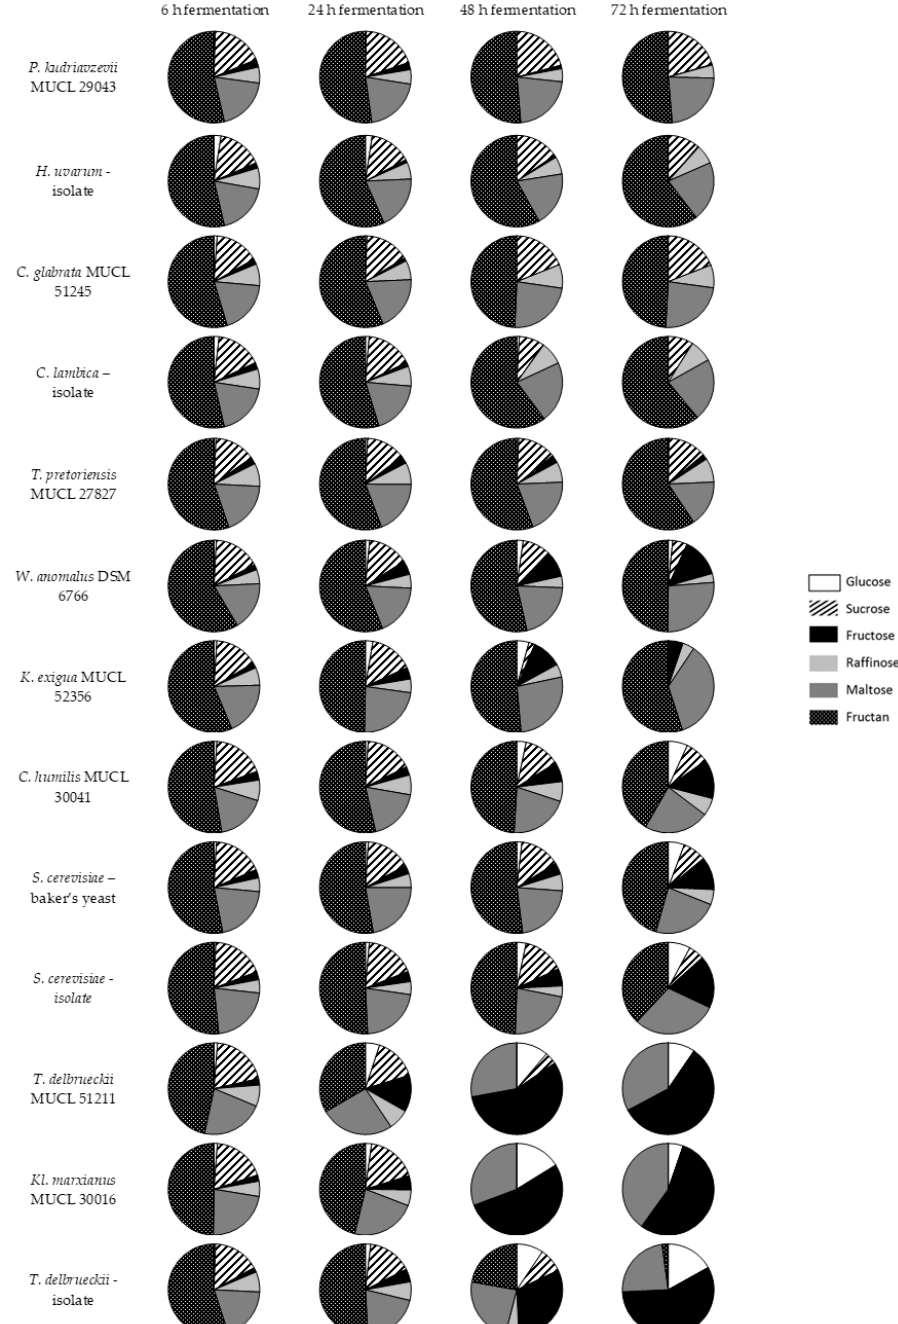
Figure 3. Fermentation profile of 13 yeasts strains over 4 measuring points, 6 h, 24 h, 48 h, and 72 h of incubation at 25 °C in a model system; examined carbohydrates: Glucose, sucrose, fructose, raffinose, maltose, and fructan.